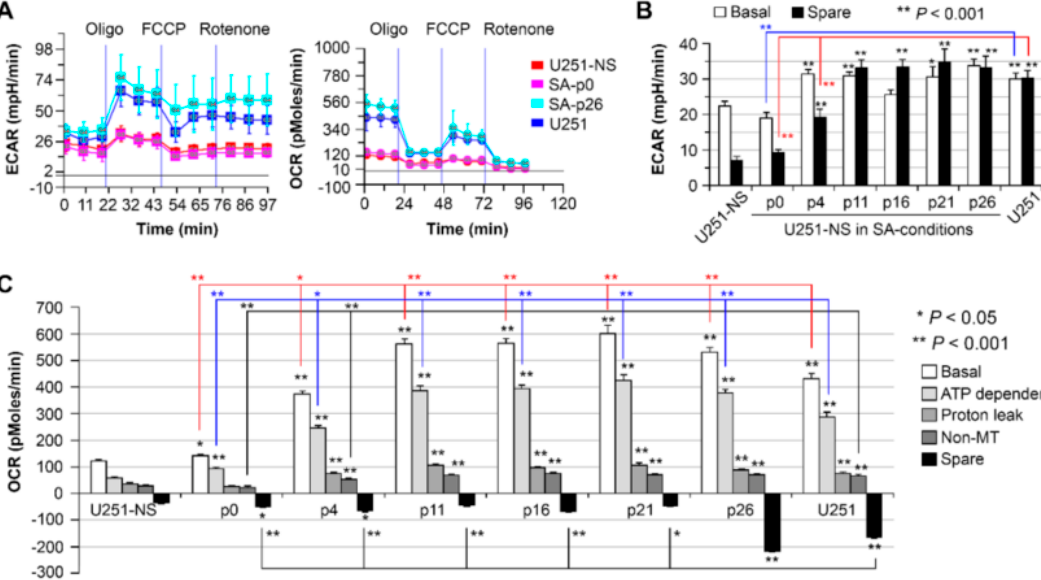
Figure 4. Differential cellular bioenergetics in U251, U251-NS and transition cultures of U251-NS cultured in SA-conditions. ( A ) Representative profiles of the key parameters of mitochondrial respiration measured by a Seahorse Bioscience XF24 Extracellular Flux Analyzer. ( B ) Basal and spare glycolytic respirations. Spare was the maximum ECAR measured during injection of mitochondrial inhibitors minus basal ECAR. ( C ) Mitochondrial (MT) and non-MT (after Rotenone) respiration consuming oxygen. Bar height and error are the mean and SEM of five replicates and three measurements at the time period shown in ( A ).